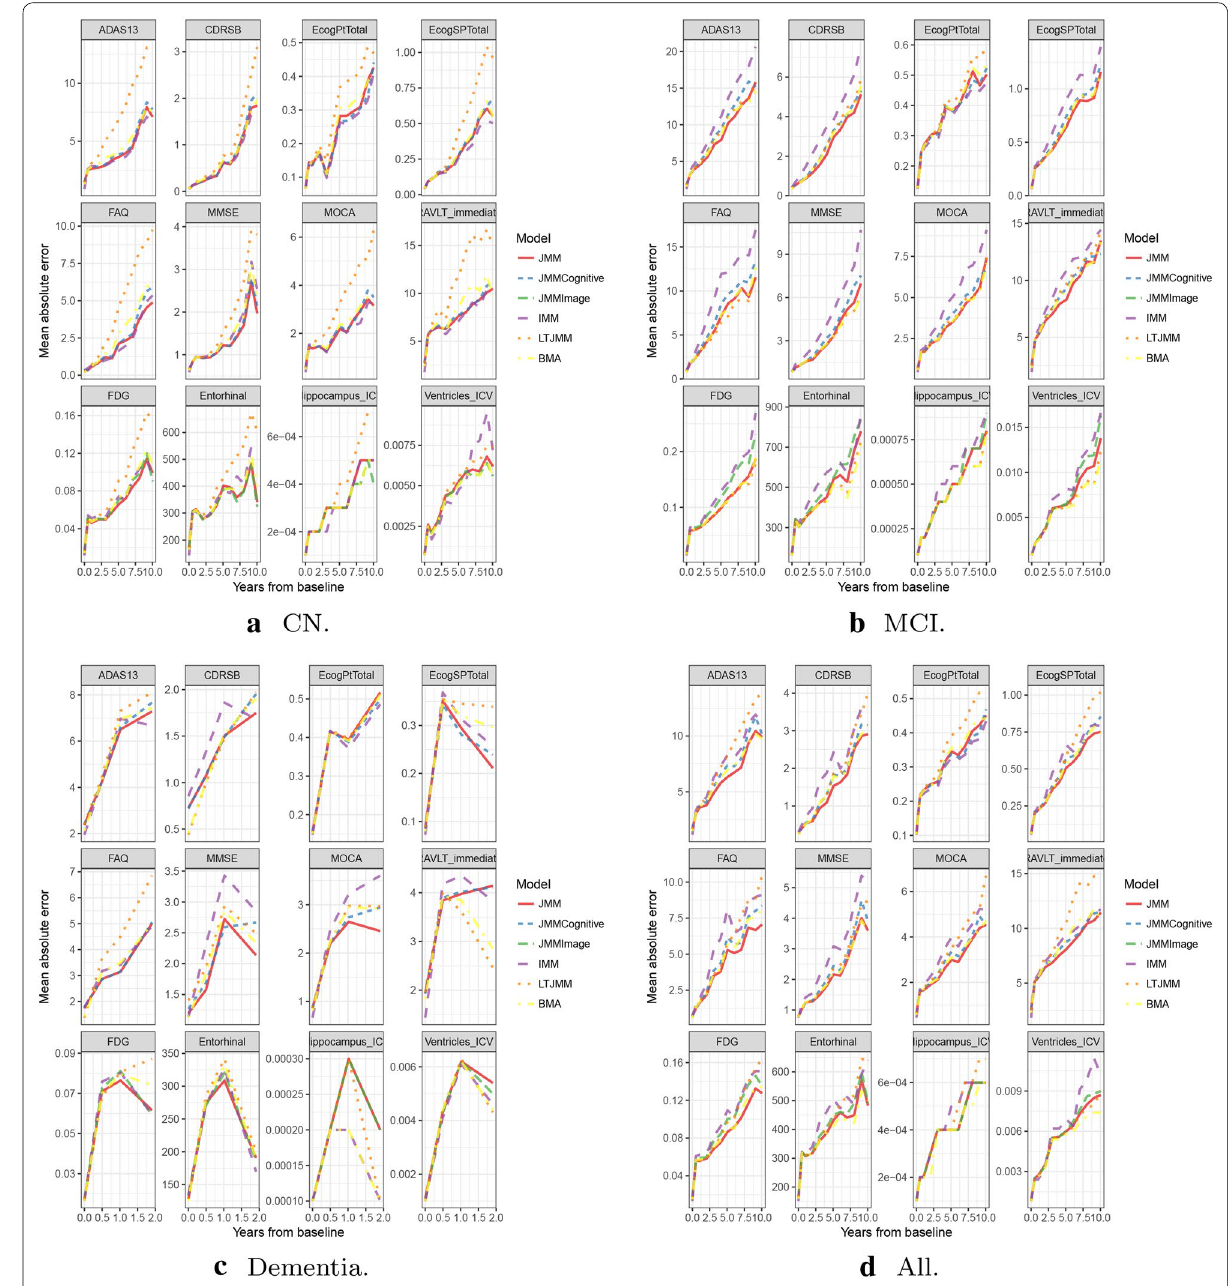
Fig. 10 Mean absolute error. CN Control, MCI mild cognitive